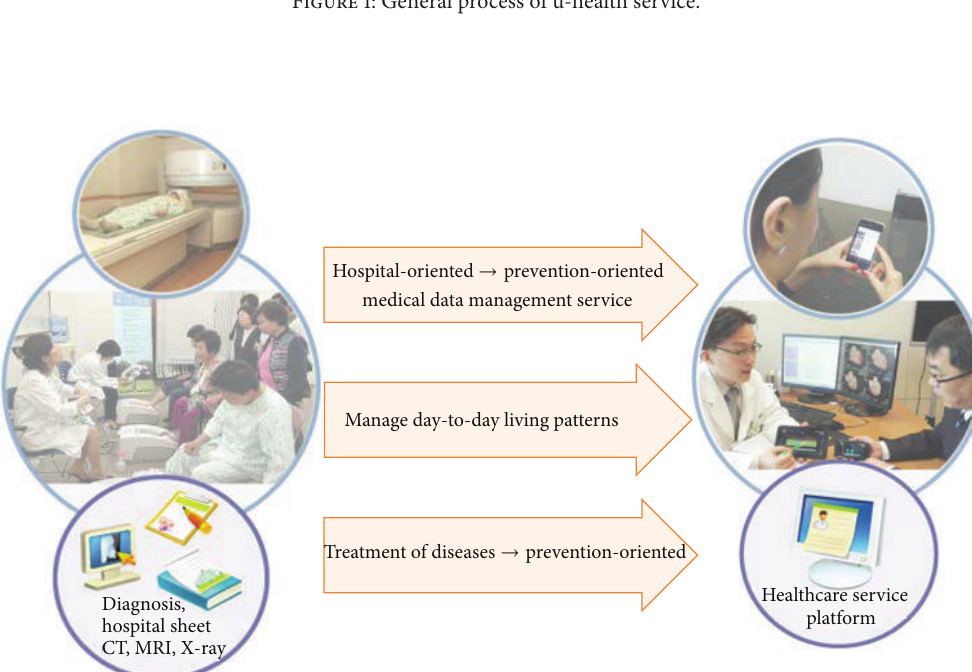
Figure 2: Patient-oriented health data management